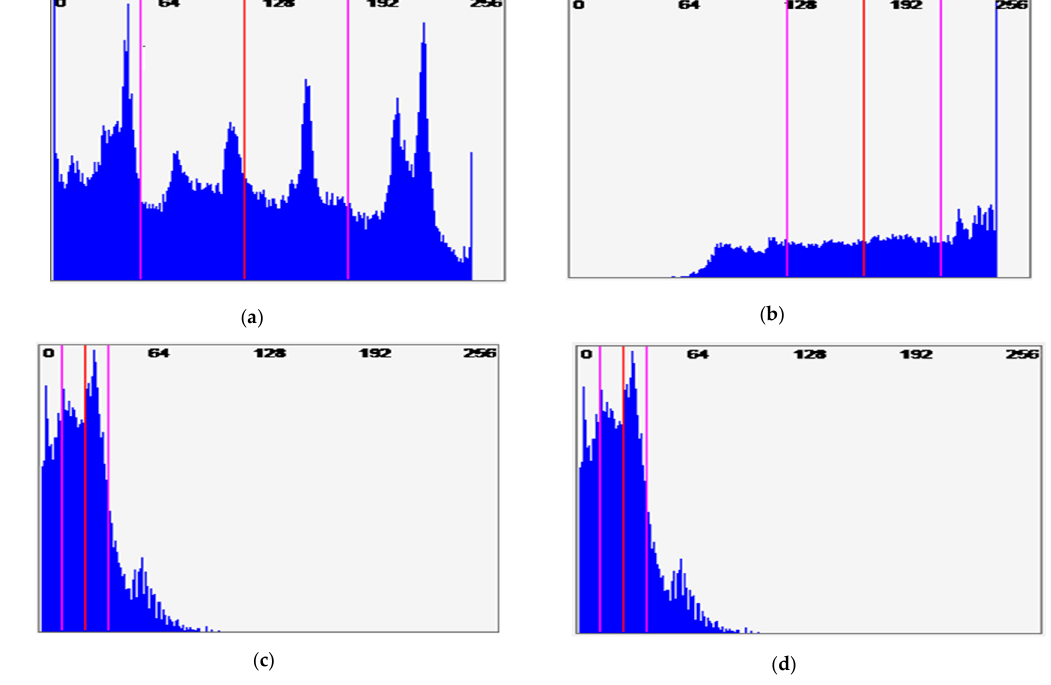
Figure 13. Comparative entropy of plaintext and encrypted mobile video. ( a ) Original frame (Frame# 123); ( b ) encrypted with XOR; ( c ) encrypted with AES; ( d ) encrypted with EXPer (Proposed).